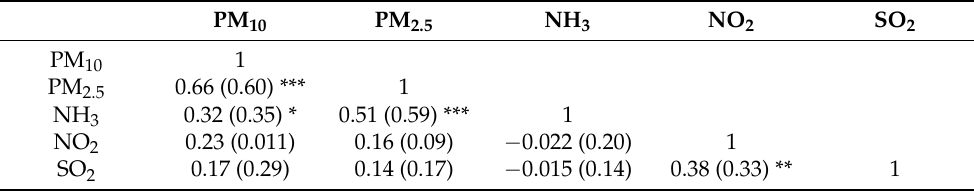
Table 1. Correlation coefficients between the annual means of PM 10 , PM 2.5 , NH 3 , NO 2 , CO, and SO 2 as measured at the national stations and by CrIS retrievals (for NH 3 ) over the Seoul Metropolitan Area (SMA) between 2015 and 2017. The correlation coefficients in the parentheses indicate correla- tions excluding Seoul and Incheon (“S” and “IN” in Figure 1), which have greater emissions from transportation and industry. The horizontal scale was set at 15 km according to CrIS footprints. PM 10 PM 2.5 NH 3 NO 2 SO 2